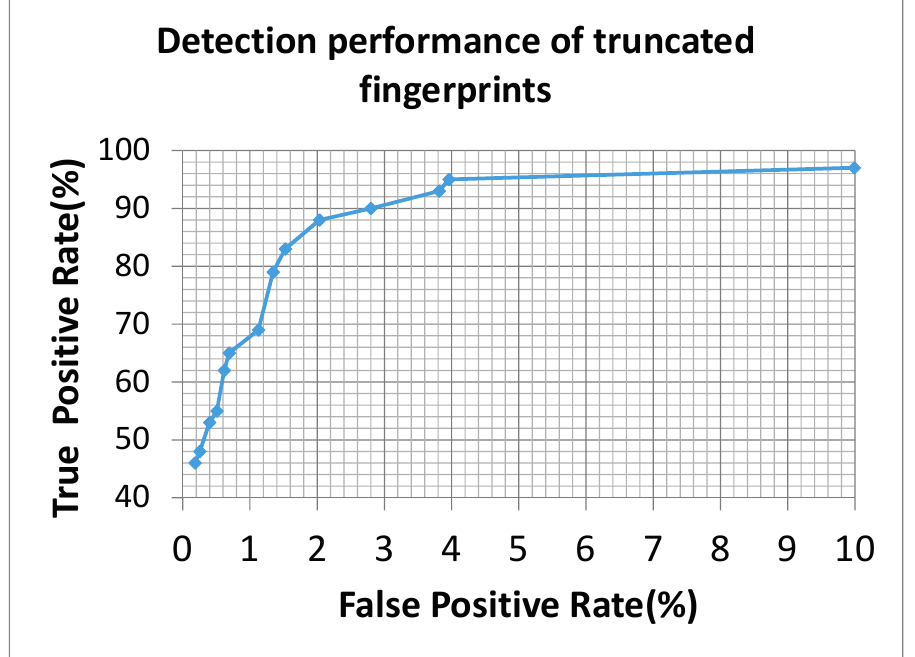
Figure 8. The ROC curve of truncated fingerprint detection is obtained by tuning threshold settings of black-and-white stripe and oriented field change. From left to right, threshold settings were strictly